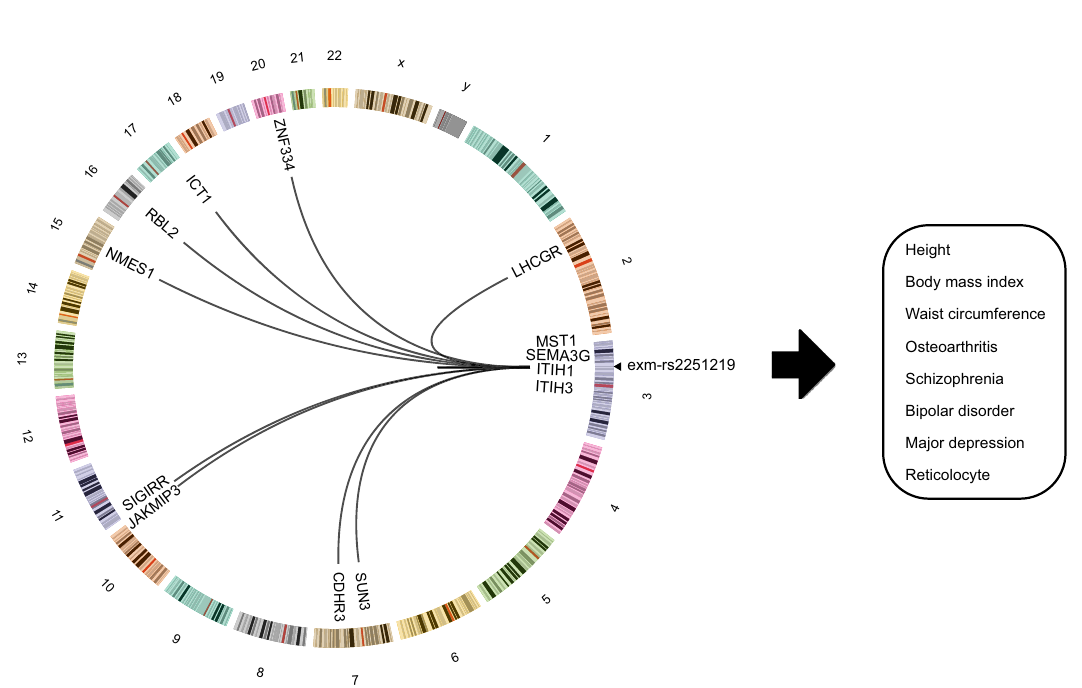
Fig. 3 Pleiotropy of rs2251219 affects many proteins and disease traits. The Circos plot highlights the effect of the variant rs2251219 (Supplementary Data 1 and 2) on 13 proteins acting in cis or trans and sharing genetics with various diseases of different etiologies. Only study-wide signi fi cant ( P < 1.92 × 10 − 10 , two-sided) genotype-to-protein associations (linear regression) are shown. Lines going from rs2251219 show links to genomic locations of the protein-encoding genes associated with the variant while numbers refer to chromosomes. The arrow points to disease-related traits that have previously been linked to that the levels of TREM2 in the cerebrospinal fl uid (CSF) re fl ect the activity of brain TREM2-triggered microglia 4,30 , while high levels of CSF TREM2 have been associated with improved cognitive functioning 31 . Supplementary Figure 4 highlights the correlation (Spearman rank) between the different proteins affected by the LOAD risk loci at chromosomes 6 and 11. The accumulated data show a directionally consistent effect at independent risk loci for LOAD converging on the same causal candidate TREM2. Further- more, a two-sample MR analysis using genetic instruments across the TREM2 and MS4A4A/MS4A6A loci and GWAS associations for LOAD in Europeans as outcome 32 provided evidence that variable TREM2 protein levels are causally related to LOAD ( P = 5.3 × 10 − 5 ) (Fig. 4d and Supplementary Data 5). The instrument rs7232 (Fig. 4d), an independent variant associated with TREM2 (Supple- mentary Data 2), is a missense variant in MS4A6A that has pre- viously been linked to LOAD (Supplemental Data 4), but the MS4A cluster has recently been shown to modulate the production of soluble TREM2 33 . This could imply that the variant is directly